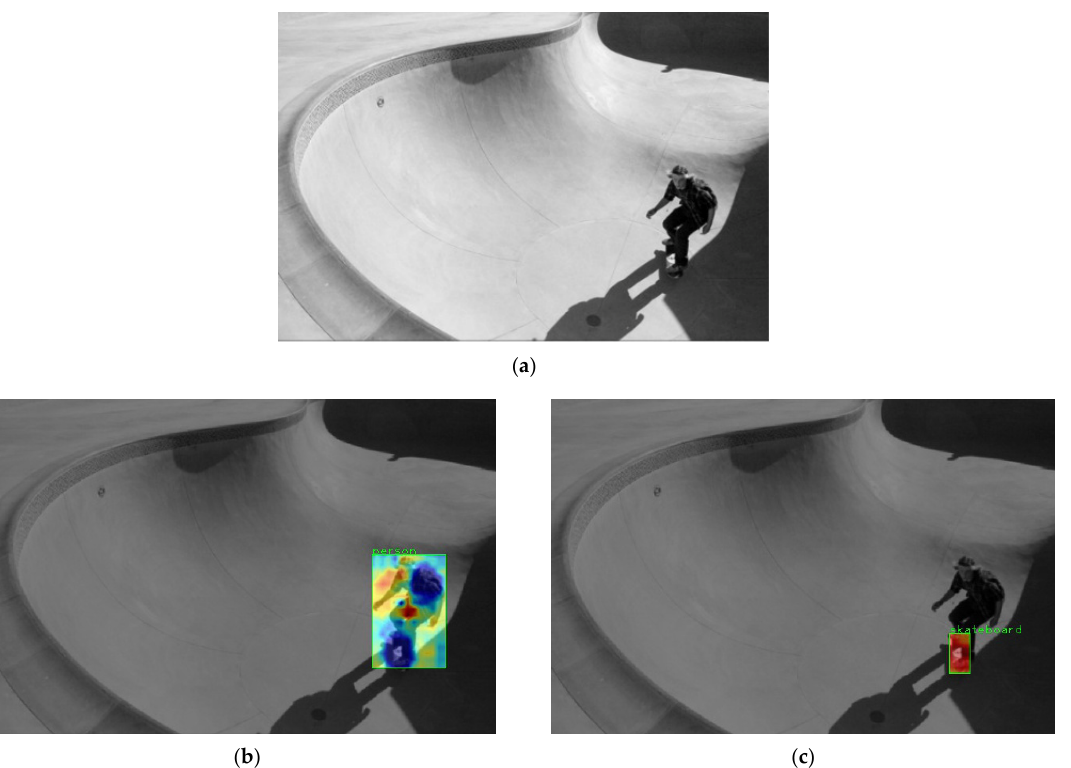
Figure 9. An example of a person riding a skateboard image from COCO dataset’s training set. Image ( a ) is an input image, and images ( b , c ) are heatmaps of class activation mapping of two object classes: a person and a skateboard respectively. The red regions of the heatmap indicate stronger activations utilized for prediction by the proposed NextDet object detection network. Darker regions of ( b , c ) indicates points in the image where no activations have occurred.